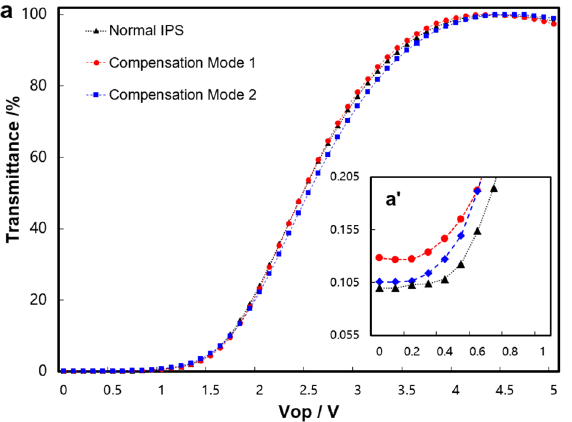
Figure 7. ( a ) The V-T curves of normal IPS, compensation mode 1 and mode 2. ( a ’) The partial enlarged V-T curve of ( a ).